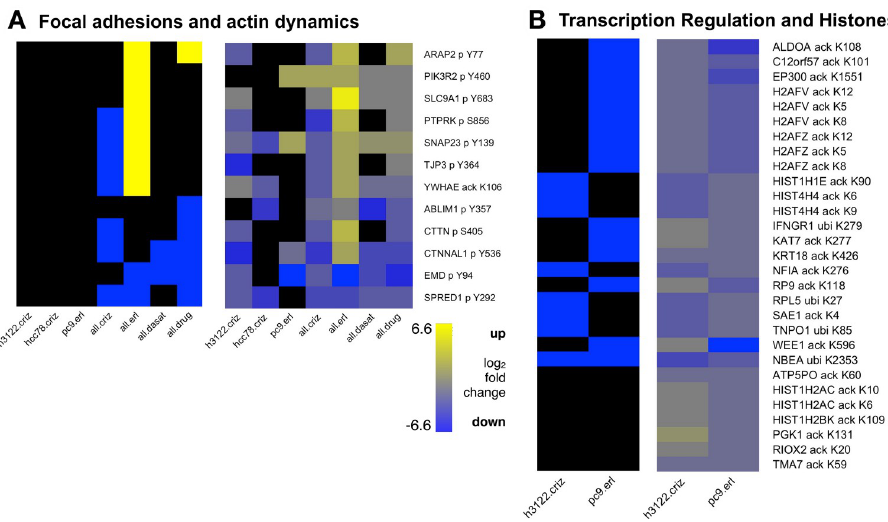
Fig 6. Heatmaps showing PTM sites in Clusters B and C. In the left hand panels, sites whose median abundance ratio in drug-treated vs. control cells was at least 2.25-fold lower are blue and those that were at least 2.25-fold higher are yellow (black is below threshold). The right hand panels show the drug-treated to control ratio (median of samples in each group) for each PTM site (see key at bottom; black represents missing data). Sample groups are as in Fig 5. (A) Sites in cluster B changed at least 2.25-fold in at least one sample group that are found in focal adhesions and/or are involved in actin dynamics. (B) Heatmaps of all PTM sites in Cluster C. Many of these sites are involved in regulation of transcription and/or are histone subunits. Sample groups: h3122.criz: H3122 cells treated with crizotinb; pc9.erl: PC9 cells treated with